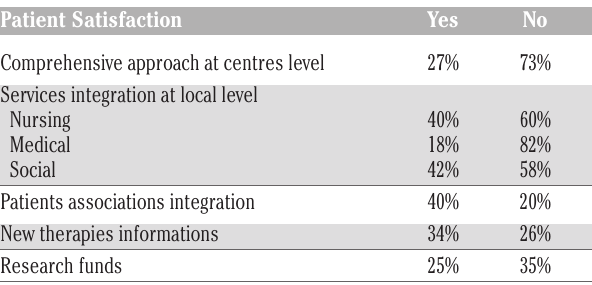
Table 5. Patients’ satisfaction with